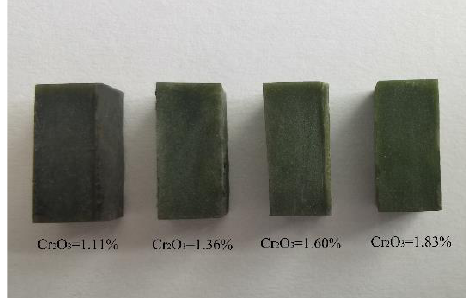
Figure 5. Samples of glass – ceramics.